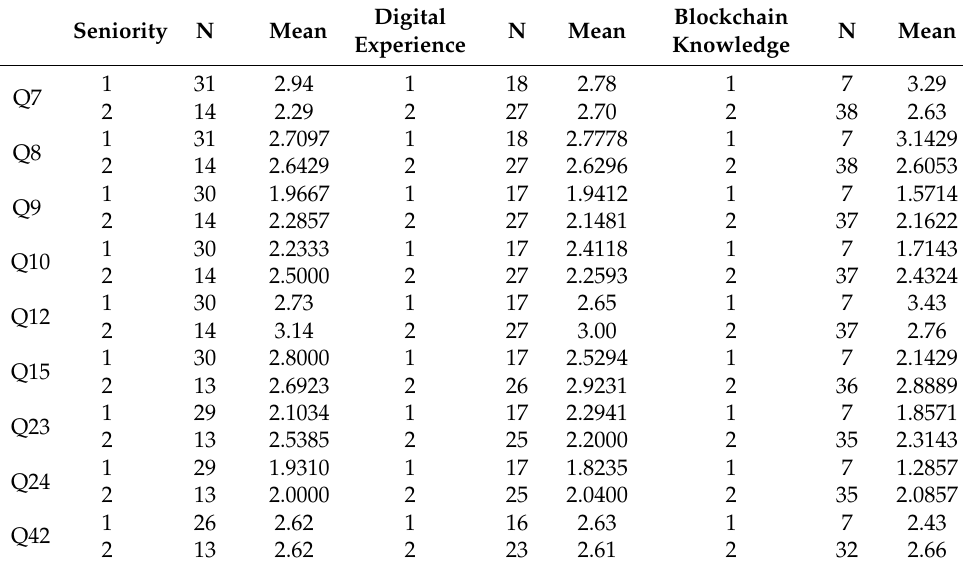
Table 12. Statistical analysis t -tests results of key survey questions.